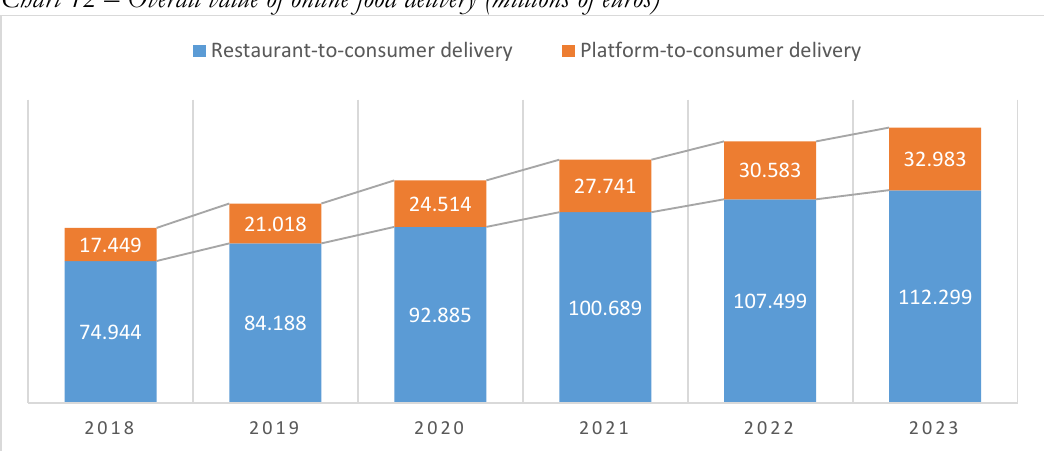
Data refer only to observer countries included in the